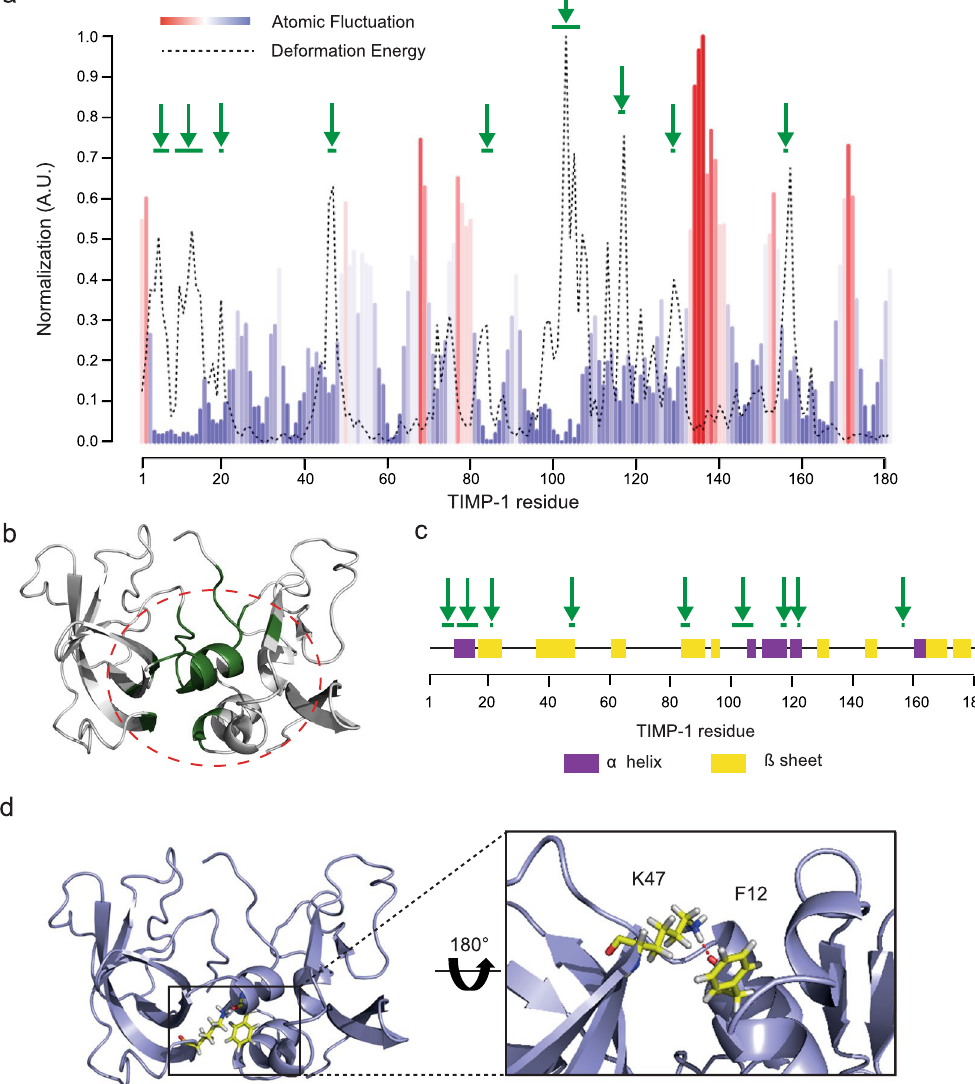
Figure 2. Identification of residues involved in TIMP-1 interdomain movements. ( a ) Superposition of the deformation energy (dotted line) and atomic fluctuation (coloured bars) data from TIMP-1 residues (numbering of the mature secreted protein) along mode 7. The green arrows point out residues or sets of residues with both high deformation energy and low C α atomic fluctuation. ( b ) Localisation in the TIMP-1 3D structure of the residues identified in ( a ) with both high deformation energy and low C α atomic fluctuation. These residues are in an area surrounded by a dotted line. ( c ) Localisation in the TIMP-1 secondary structure of the residues identified in ( a ) with both high deformation energy and low C α atomic fluctuation (green arrows). α helices are defined by the purple area and β sheets by the yellow area. ( d ) Left: localisation in the TIMP-1 3D structure of F12 and K47 residues. Right: hydrogen bond formed between the carbonyl oxygen of the F12 backbone and the K47 side